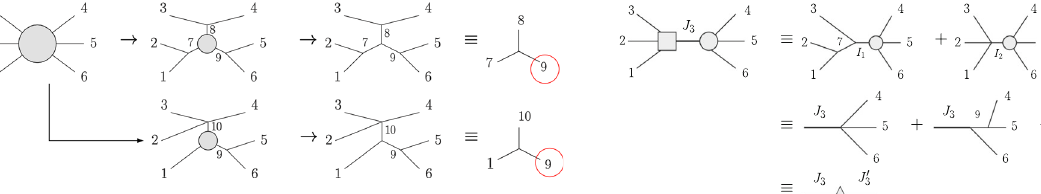
Fig. 1 Recycling in MG5aMC. Starting from out to in, MG5aMC cal- culates propagators as off-shell currents which it then caches. When two diagrams share an off-shell current such as current 9, there is no need to recalculate this current, and the cached version is instead used. The value of the Feynman diagram is then calculated by contracting the remaining, often internal, currents